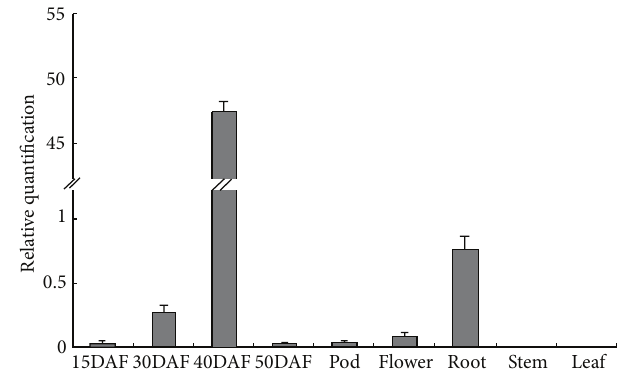
Figure 3: Real-time RT-PCR analysis of GmNAC5 expression in various soybean tissues. DAF: days after